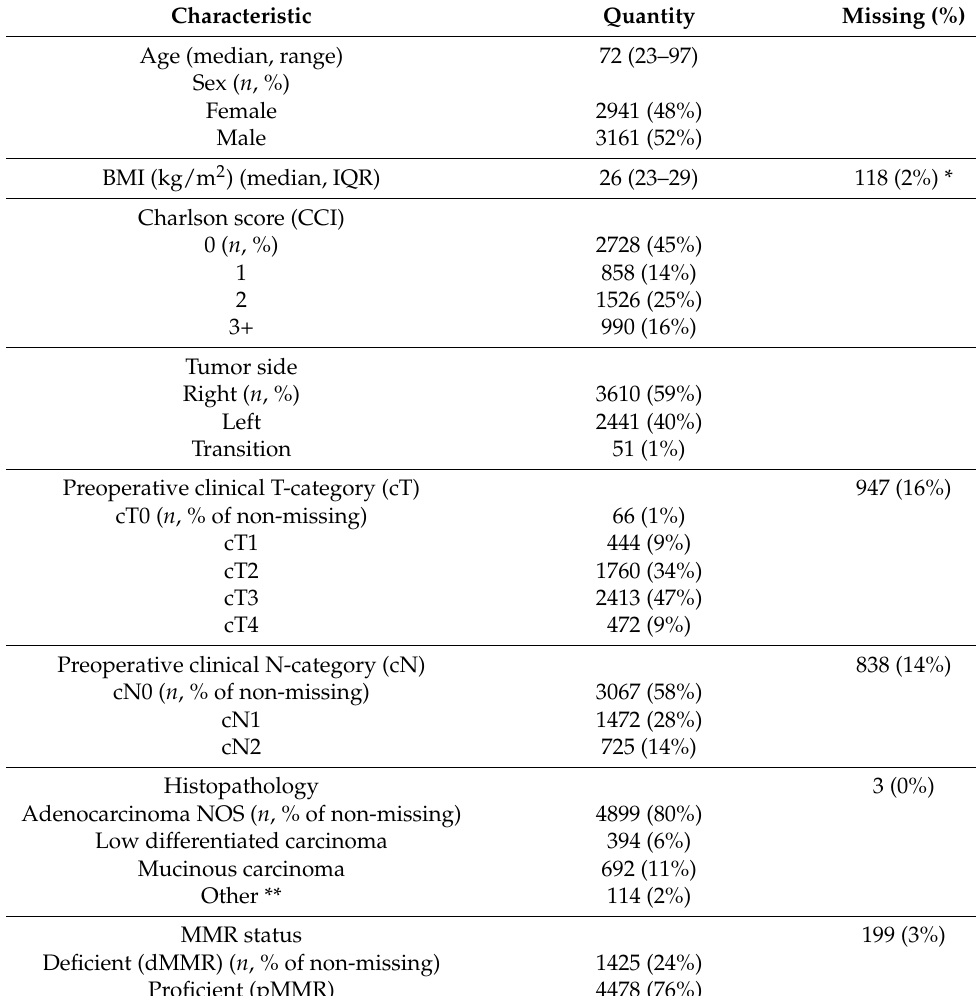
Table 1. Baseline characteristics of 6102 patients with colon cancer.